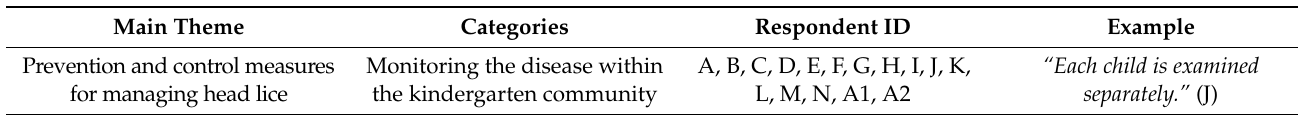
Table 3. Thematic analysis of categories and verbatim quotes for theme one: “ Prevention and control measures for managing head lice